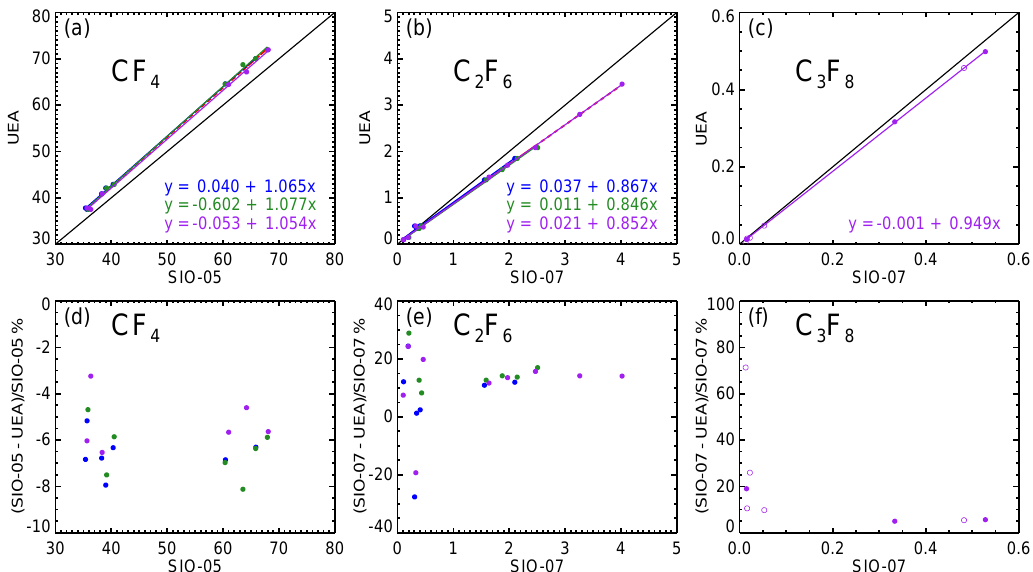
Figure A1. (a) Circles show measurements of CF 4 made at UEA plotted against measurements at the same firn depths measured at Aspendale or Cape Grim on the Medusa system, for firn sites DSSW20K, DSSW19K and SPO 2001. The Medusa measurements were made at three separate times by different people, and these are plotted in different colours. Linear fits to these data are shown with their equations. The red dashed line shows the fit to all measurements, given in the main text. The black line shows the 1 : 1 line. (b) As in (a) but for C 2 F 6 with measurements from DSSW20K, DSSW19K, SPO 2001 and NEEM 2008. (c) Medusa measurements of C 3 F 8 at NEEM 2008 plotted against UEA measurements. The filled circles show measurements at the same depths (these data were used to determine the linear fit), while the open circles show measurements at similar depths. (d–f) Same data as in (a–c) but plotted as a percent difference.